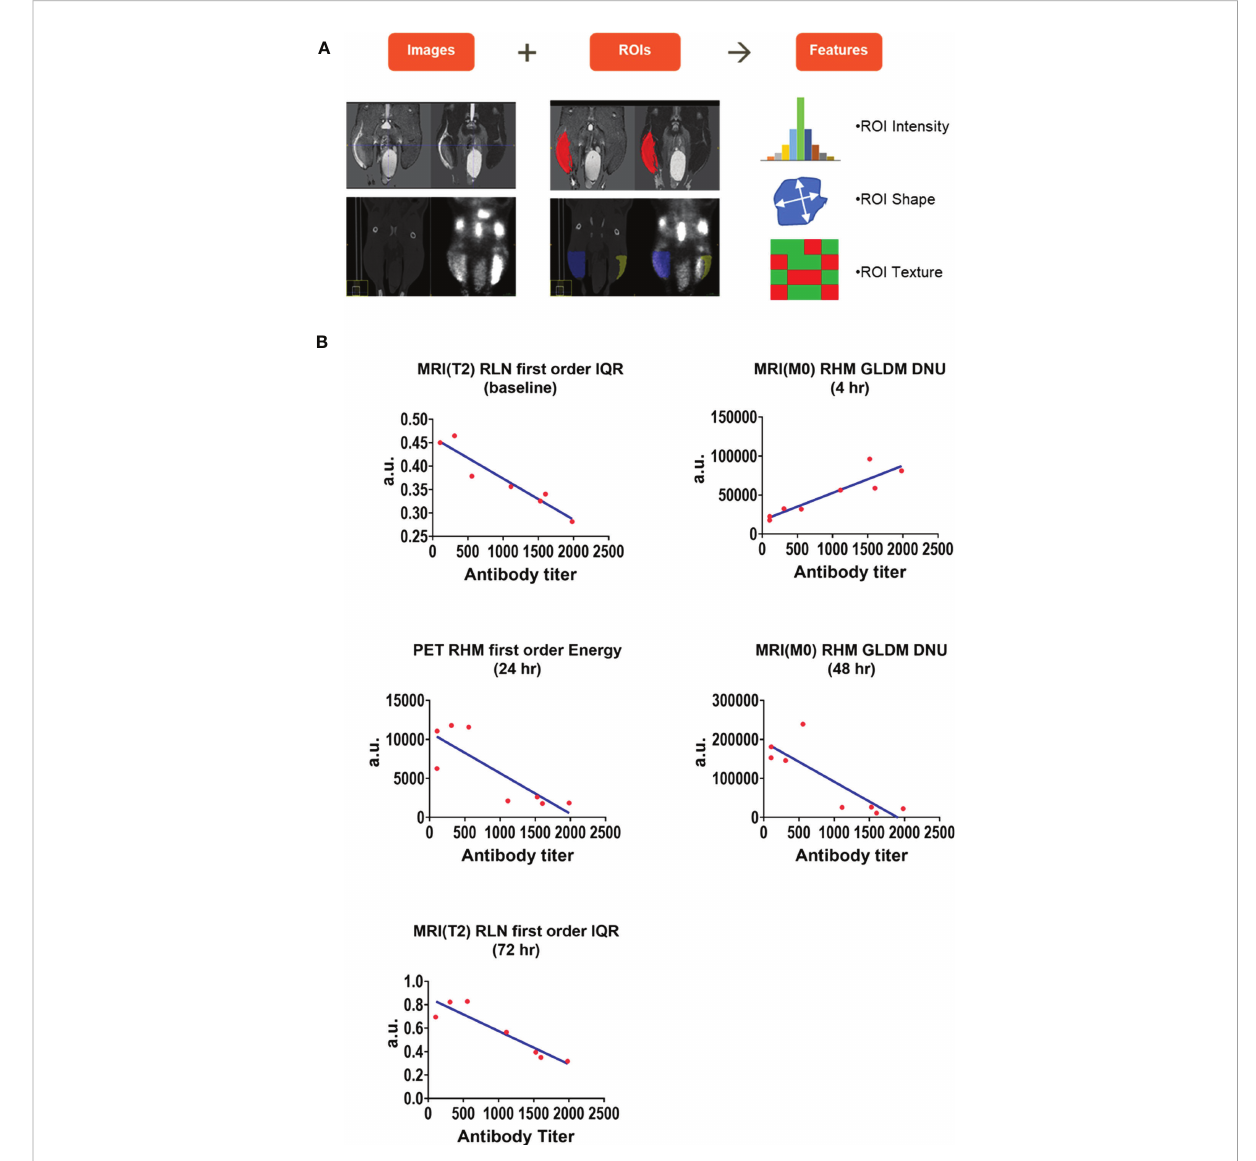
FIGURE 7 Radiomics analysis of right hindlimb and right draining lymph node images. Radiomics features were extracted from the Prime-Boost cohort images of hindlimb and draining lymph node to fi nd predictors of immune response. 107 image features including region of interest (ROI) intensity, ROI shape, and ROI texture were extracted from each MRI, PET, and CT image of the right hindlimb and draining popliteal lymph node (A) . Hindlimb and draining lymph node features were correlated with biomarkers of immune response including CMV gB antibody titers at each timepoint and highly correlated features are presented (B) . a.u. (arbitrary units), IQR (interquartile range), GLDM DNU (Gray Level Dependence Matrix Dependence